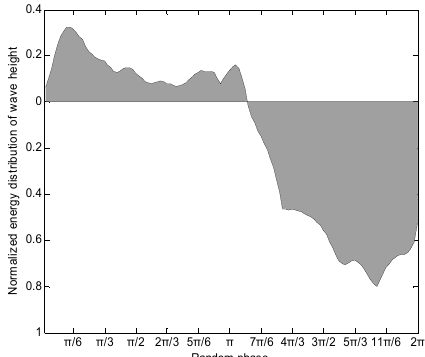
Figure 9. Normalized average energy distribution of wave heights on both sides in the horizontal direction based on Monte Carlo method.